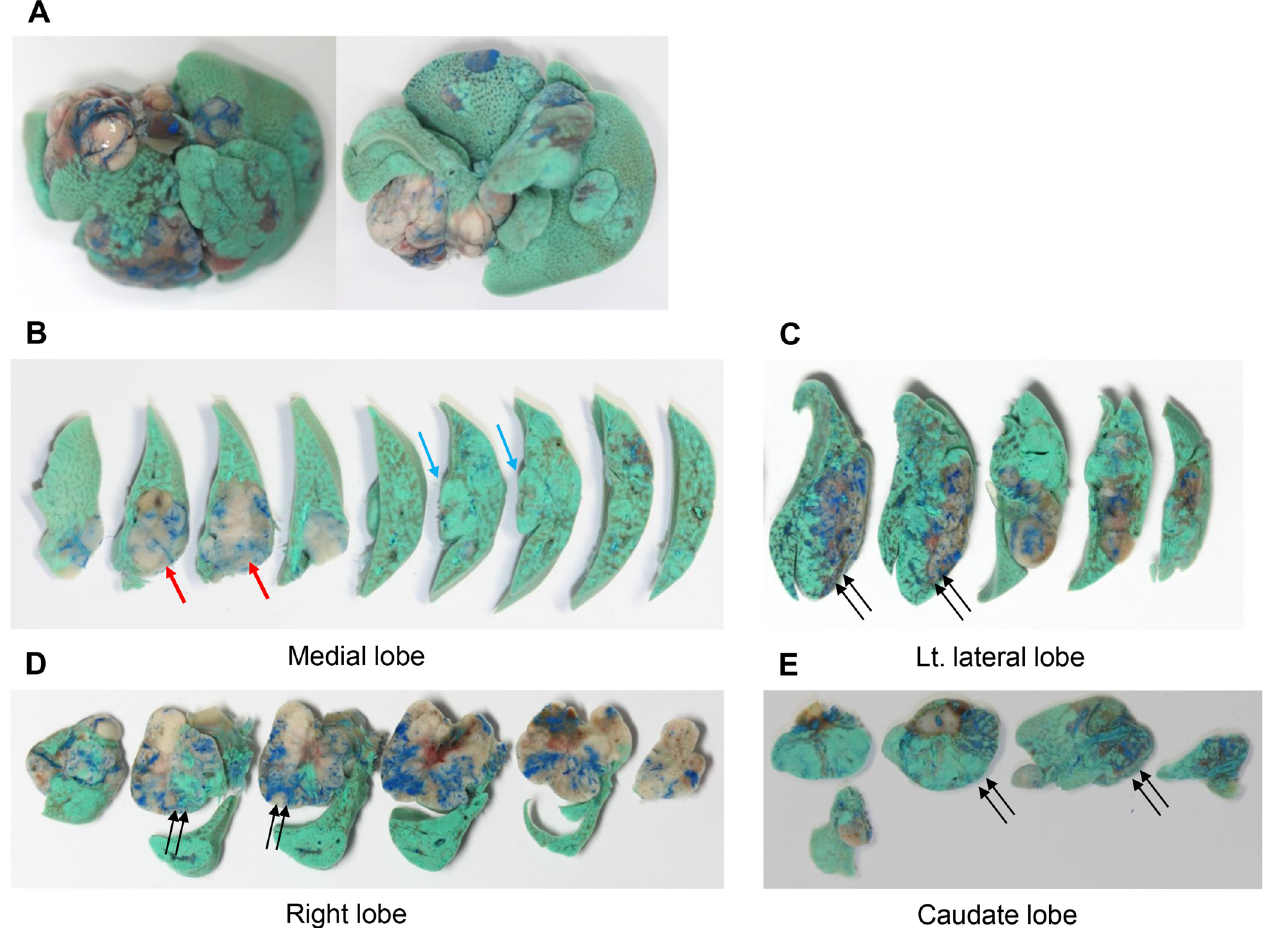
Fig 2. Liver dual angiography performed in a H-ras12V over-expressing transgenic mouse that developed multiple spontaneous tumors. Selective latex arteriography (blue latex) and portography (green acrylic paint) were sequentially conducted. Gross images of (A) the whole liver superior aspect (left) and inferior aspect (right), and sectioned slices of (B) the medial lobe, (C) left lateral lobe, (D) right lobe, and (E) caudate lobe. Nodules were perfused by arterial supply (red arrow), portal venous supply (blue arrow), or both (double